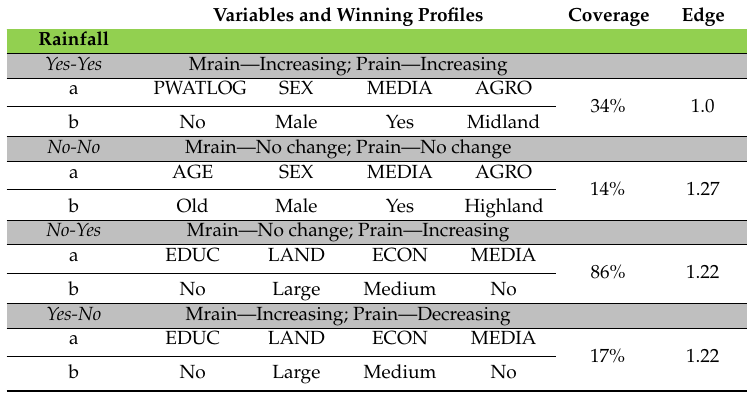
Table 7. Winning profiles of convergence and divergence between measurement and farmers’ perceptions of rainfall and temperature